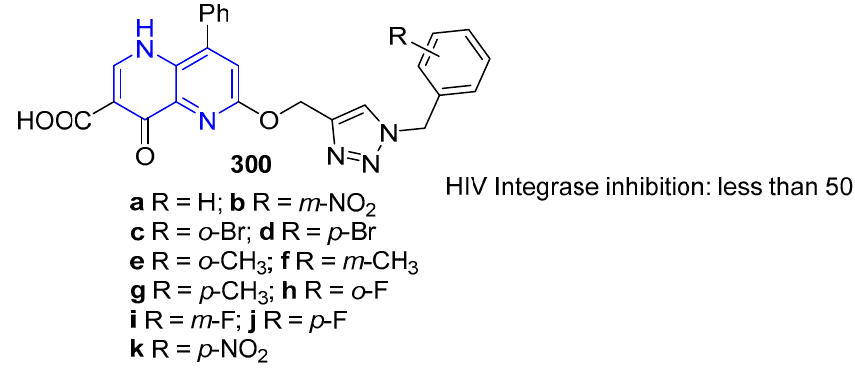
Figure 24. Inhibition of HIV integrase by triazole substituted 1,5-naphthyridine derivatives.